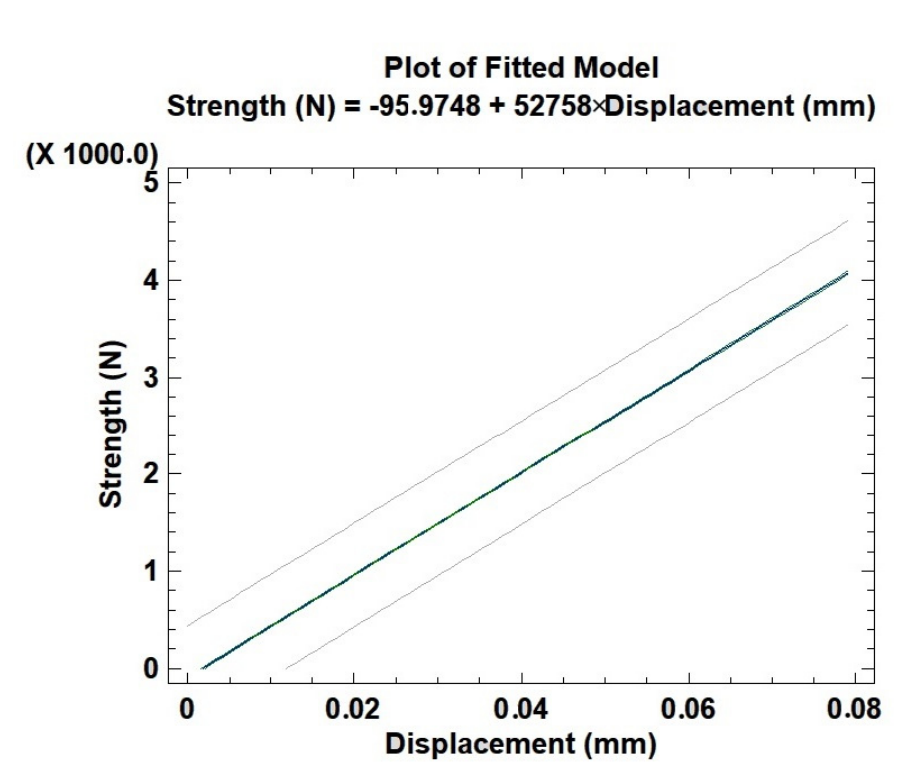
Figure 13. Graph of the adjusted model Test 2. Composite material 60% fly ash (D: 20 mm/E: 70 mm).